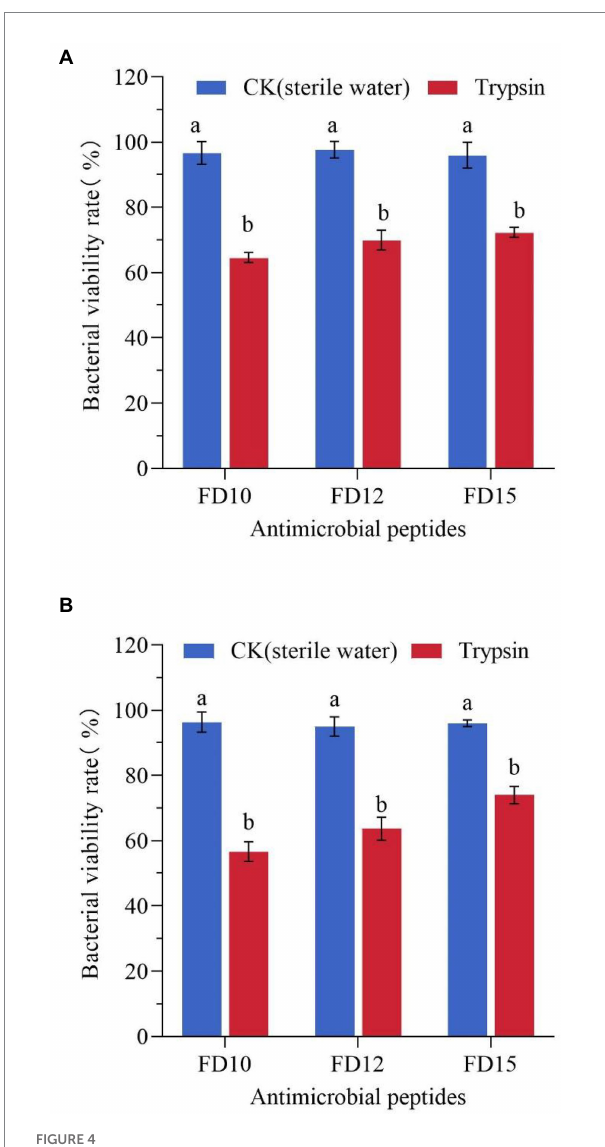
FIGURE 4 Changes in the antimicrobial activity of AMPs against (A) E. coli ( n = 3) and (B) S. aureus CMCC(B) 26003 ( n = 3) after trypsin treatment. E. coli or S. aureus CMCC(B) 26003 were treated with 2× MIC FD10, FD12, or FD15 and the same volume of 1 mg/mL trypsin or sterile water (control). Different lowercase letters (a, b) indicate a significant difference ( p < 0.05) based on one-way